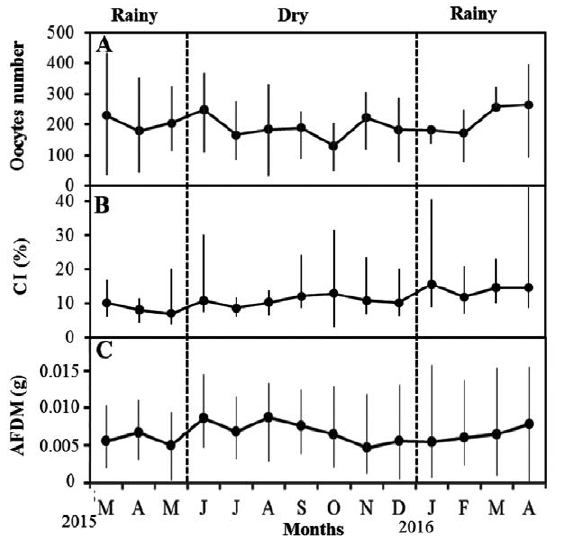
Fig. 4. – A, monthly variation of the mean number of oocytes; B, mean condition index (%); and C, mean ash-free dry mass (g) of Donax striatus during the study